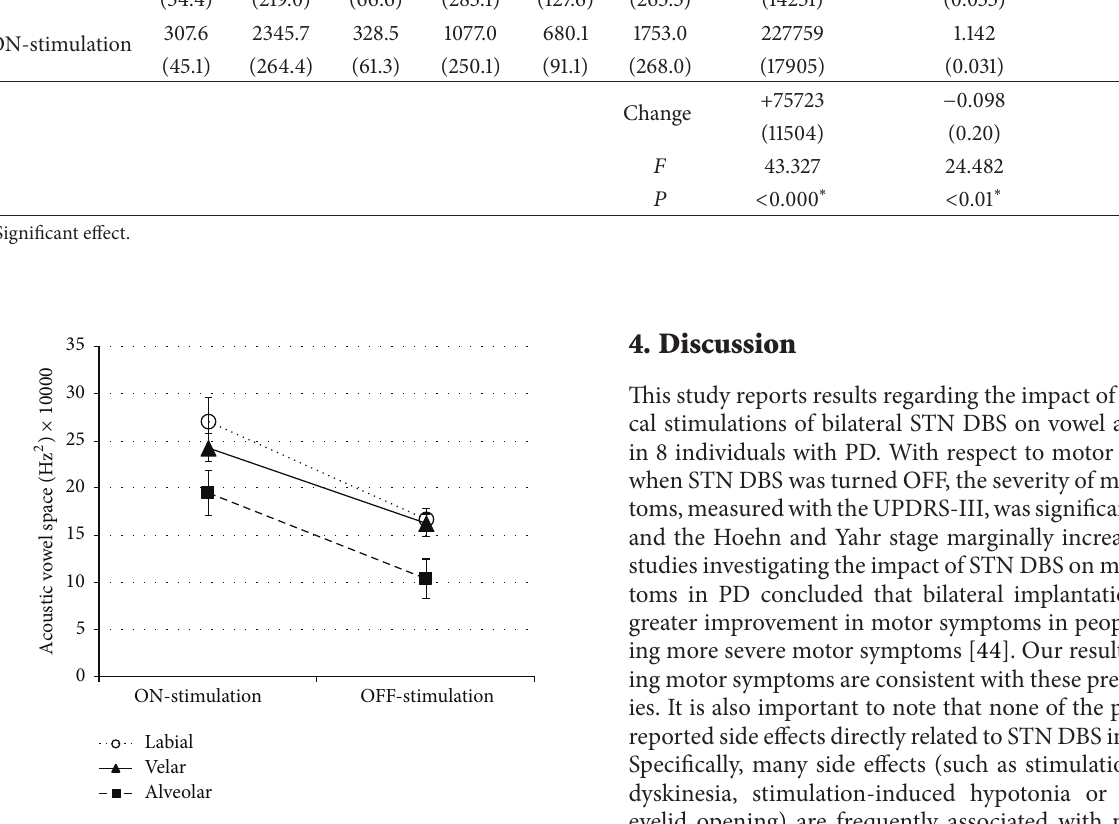
Figure 2: Acoustic vowel space values for vowels in labial, velar, and alveolar context in both stimulation